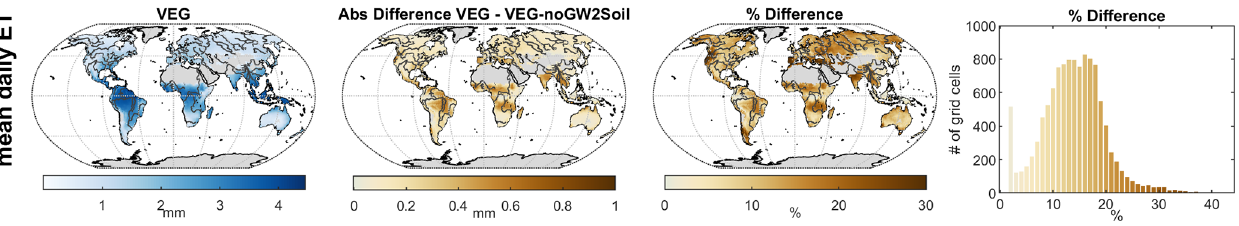
Figure 9. Total evapotranspiration (ET) of VEG with capillary flux from the deep soil water storage (left) and difference compared to a model version without capillary flux in millimetres (right map) and as a percentage difference